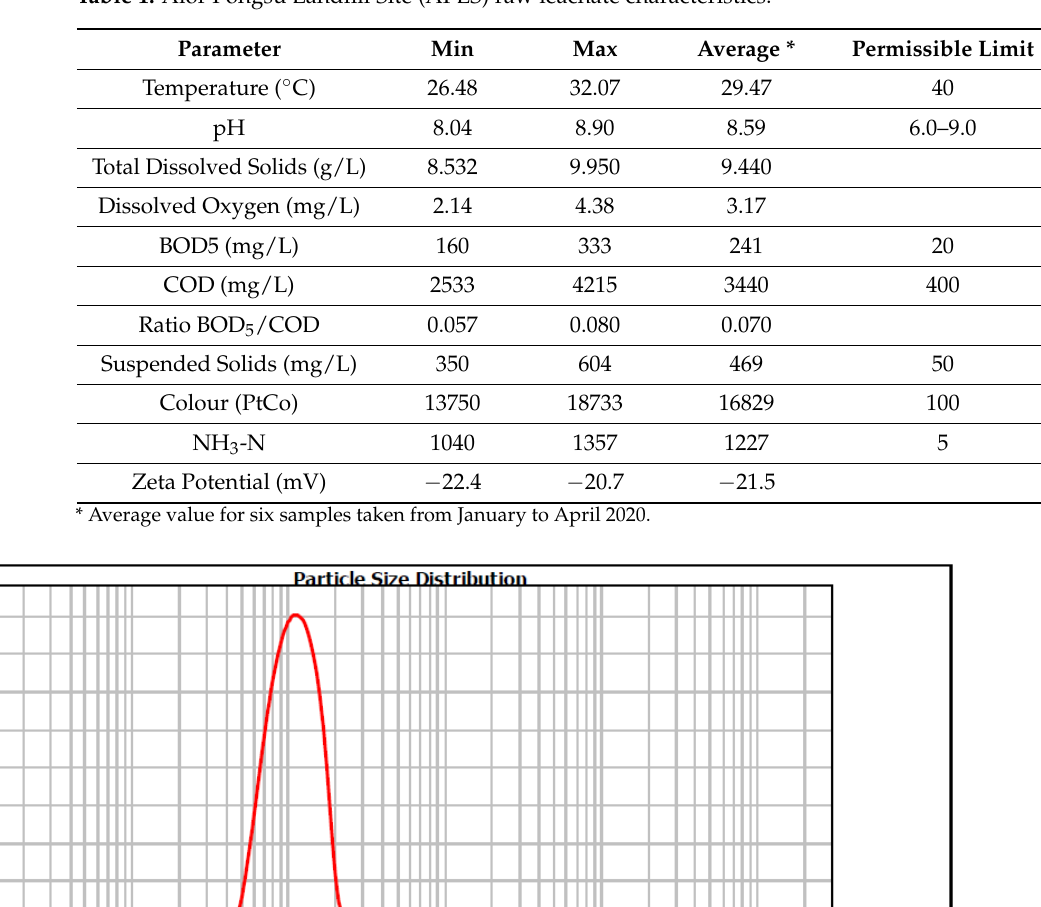
Table 1. Alor Pongsu Landfill Site (APLS) raw leachate characteristics.